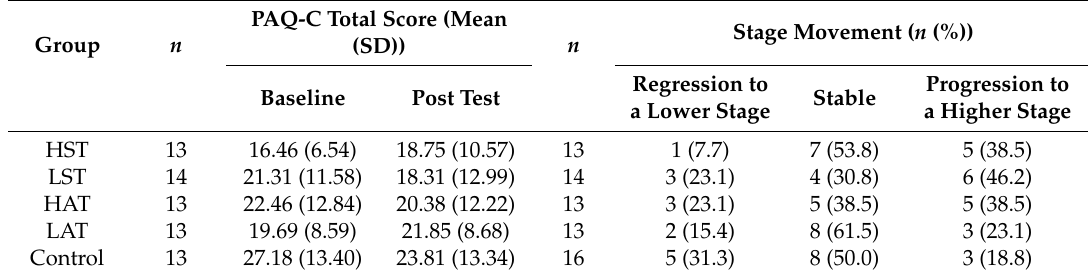
Table 2. Participants’ PAQ-C score and stage movement stratified by group and time.